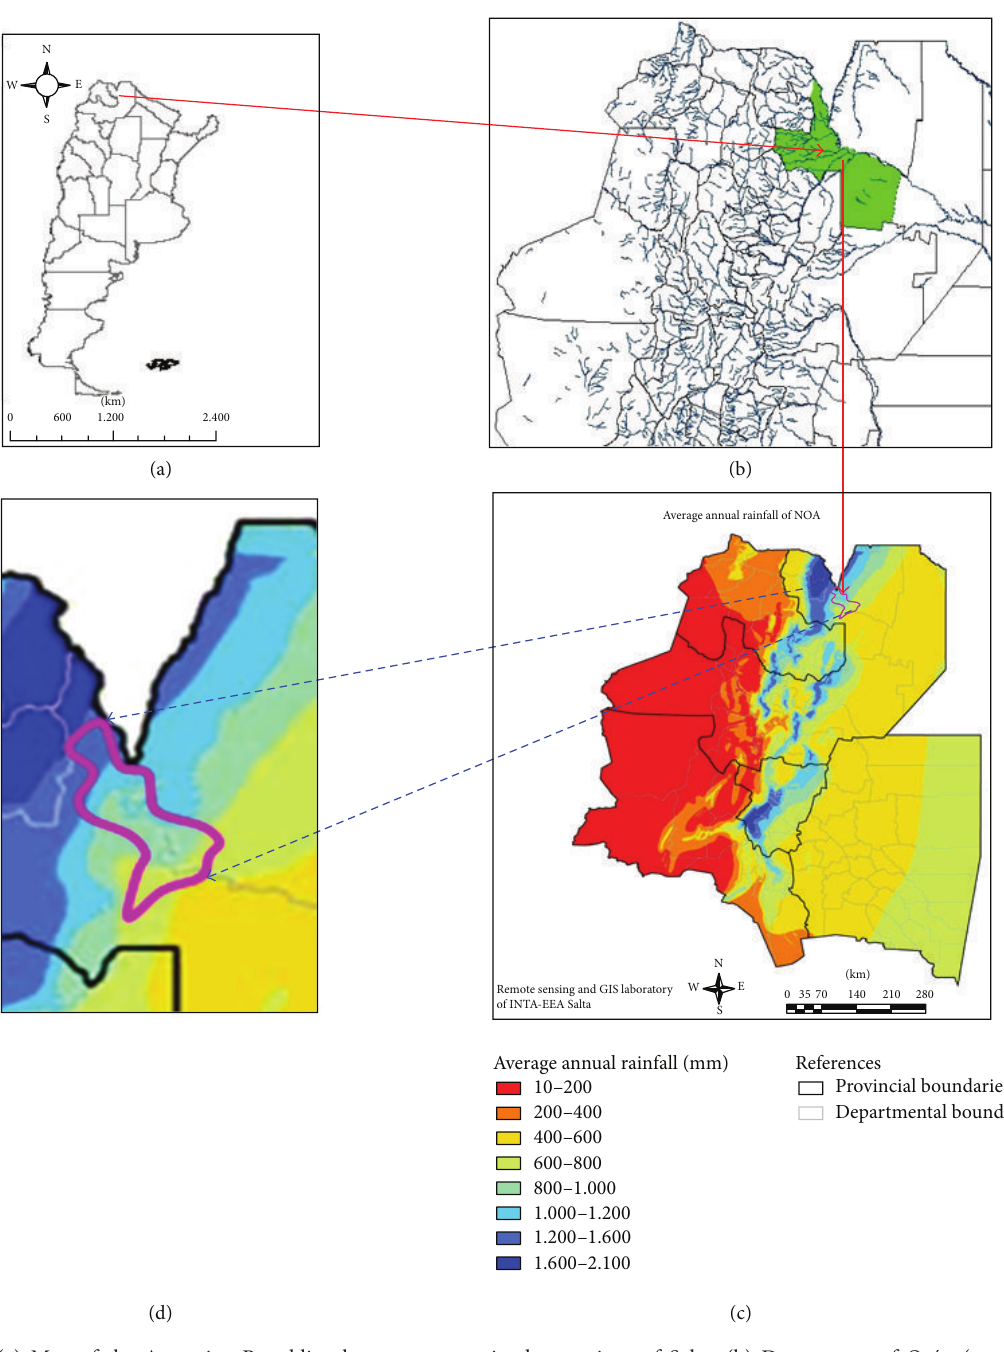
Figure 1: (a) Map of the Argentina Republic, the arrow starts in the province of Salta. (b) Department of Or´an (green), arrow ends approximately in the region of study, taken from Instituto Geogr´afico Nacional (IGN) [28]. (c) Map of rainfall in the northwestern region of Argentina, taken from Instituto Nacional de Tecnolog´ıa Agropecuaria (INTA) [29]. (d) Approximate region of the department of Or´an which includes the cities and towns where they have registered the number of cases upon which the incidence of American Tegumentary Leishmaniasis was calculated (inside the violet